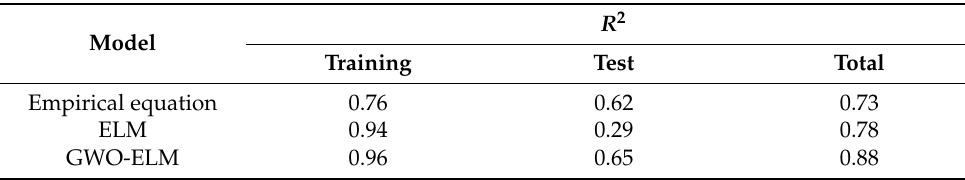
Figure 11. Comparison between measured and predicted PPV: ( a ) GWO-ELM; ( b ) ELM; ( c ) Empirical equation. Table 4. Statistical criteria for predicting PPV.